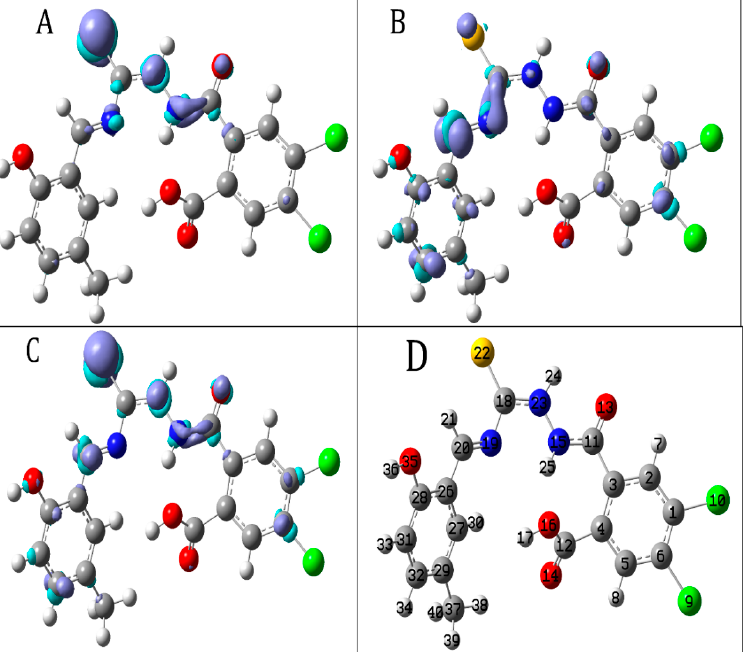
Figure 6. Fukui function describing the sites (lobes) on compound 5 more susceptible to ( A ) electro ‐ philic [ f − (r)] attacks, ( B ) nucleophilic [ f + (r)] attacks, ( C ) radical [ f 0 (r)] attacks, and ( D ) labeled